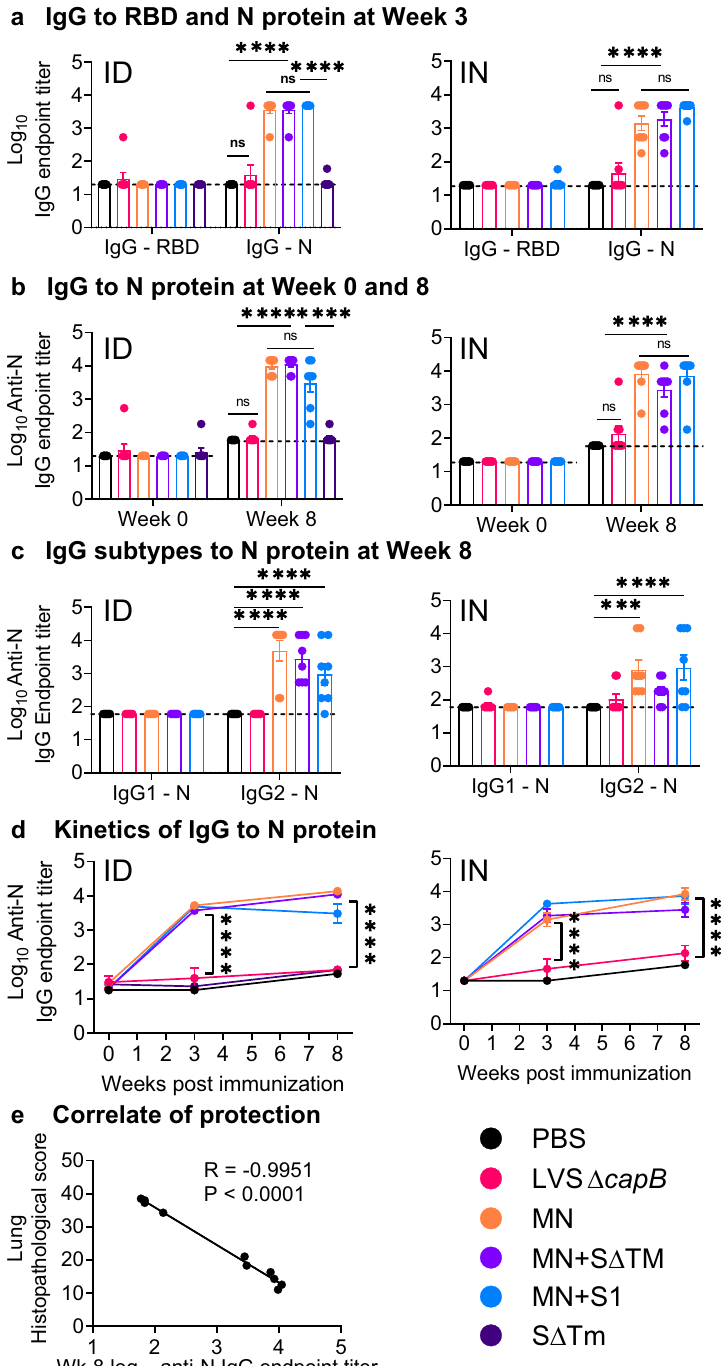
Fig. 7 Humoral immune response and correlate of protection. Hamsters were immunized ID or IN as described in Fig. 2. a Sera were evaluated for IgG speci fi c to S RBD and N protein three weeks after a single immunization ID (left) or IN (right). b Sera were evaluated for IgG speci fi c to N protein just prior to immunization at Week 0 and just prior to challenge at Week 8 in hamsters immunized ID (left) or IN (right). c Sera were evaluated for IgG subtypes (IgG1 and IgG2) speci fi c to N protein at Week 8 in hamsters immunized ID (left) or IN (right). a – c , each symbol represents one animal. d The antibody titers displayed in ( a ) and ( b ) are plotted over time. a – d Data are mean ± SE. *** P < 0.001; **** P < 0.0001; ns, not signi fi cant by two-way ANOVA with Tukey ’ s multiple comparisons (GraphPad Prism 8.4.3). e Correlation between mean IgG N titer at Week 8 and mean lung histopathology score on Day 7 post challenge (sum of cranial and caudal lung as shown in Fig. 3a) for all groups (ID and